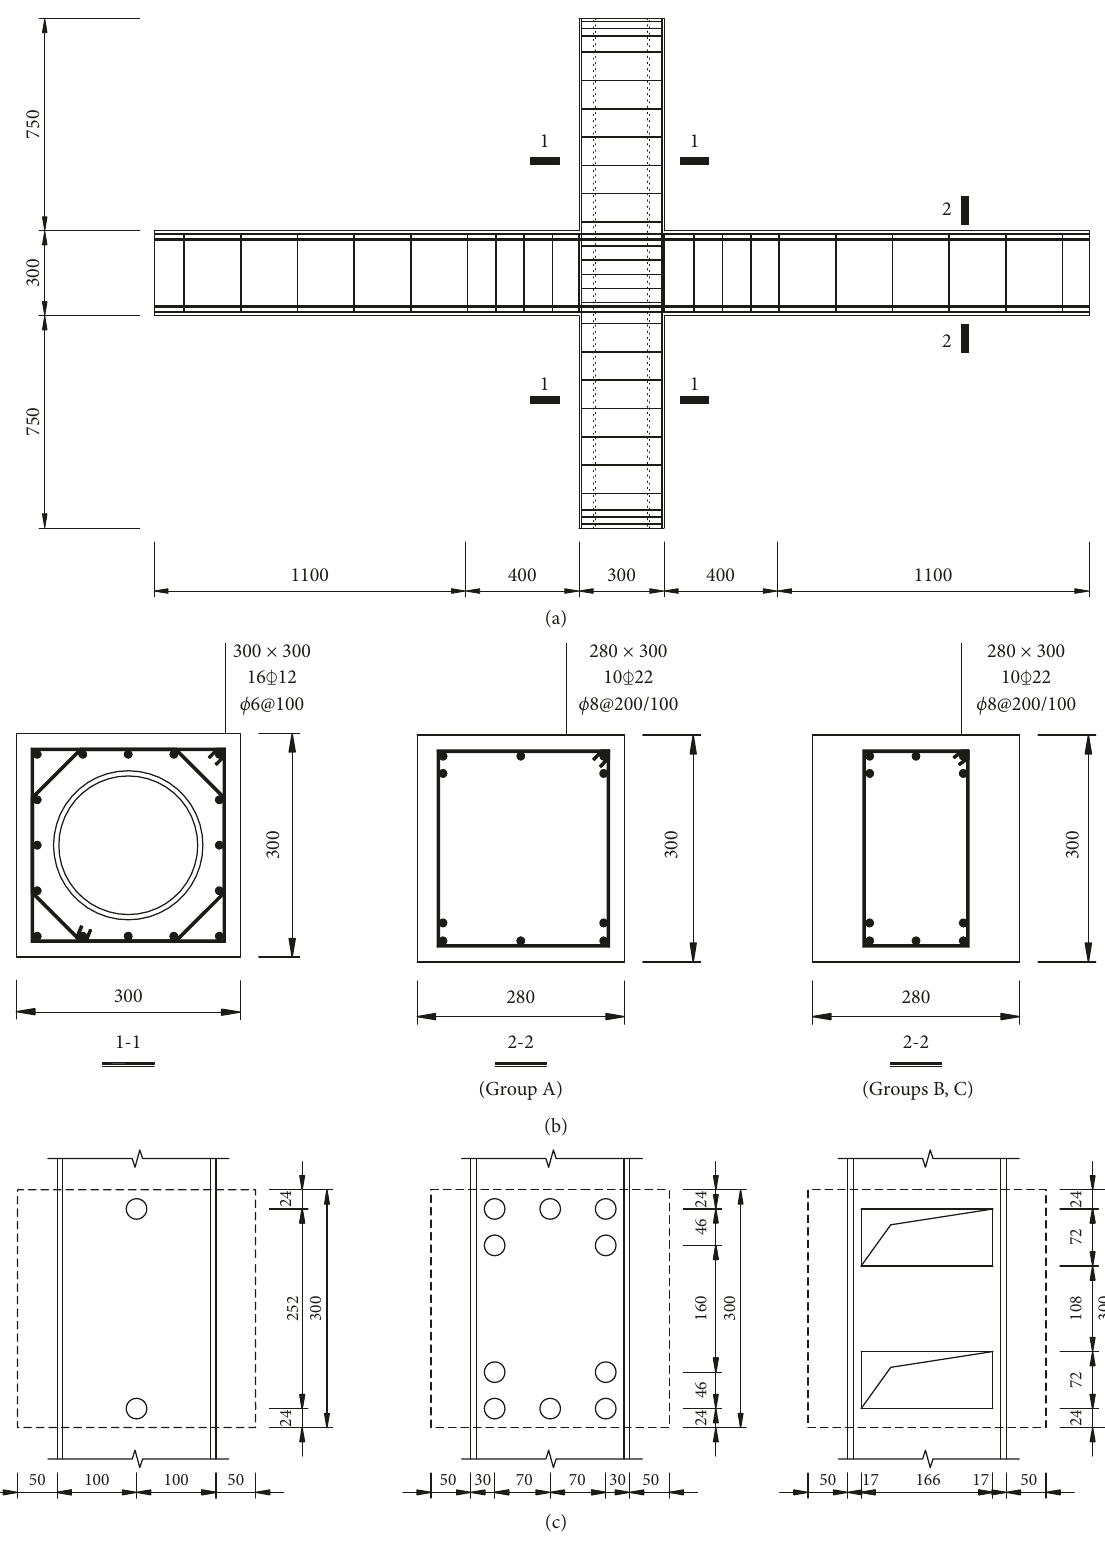
Figure 2: Size and structure of specimens. (a) Specimen size. (b) Section construction of column and beam. (c) Opening hole type of steel